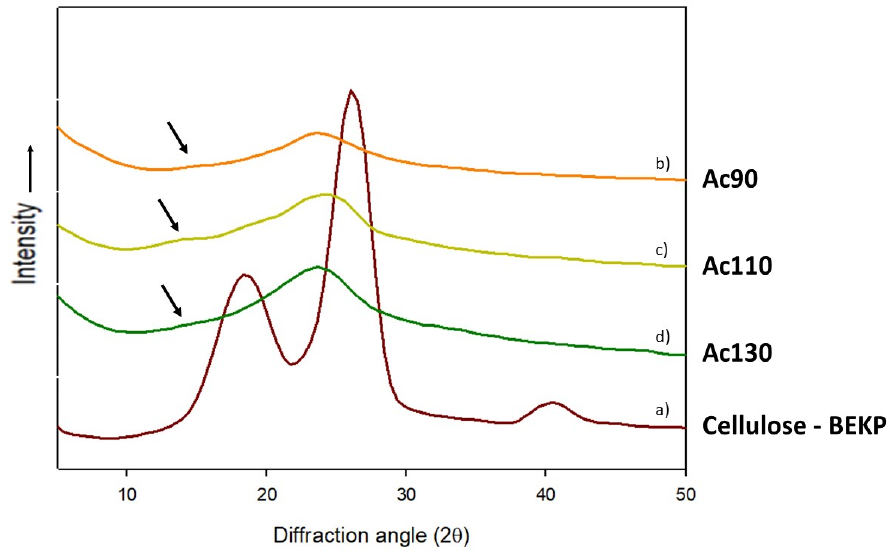
Figure 7. XRD profiles of ( a ) cellulose pulp—BEKP, ( b ) Ac90, ( c ) Ac110, ( d ) Ac130.